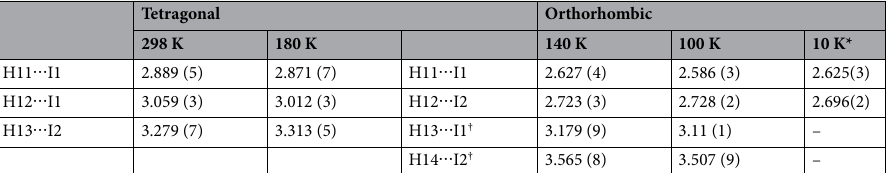
Tetragonal Orthorhombic 298 K 180